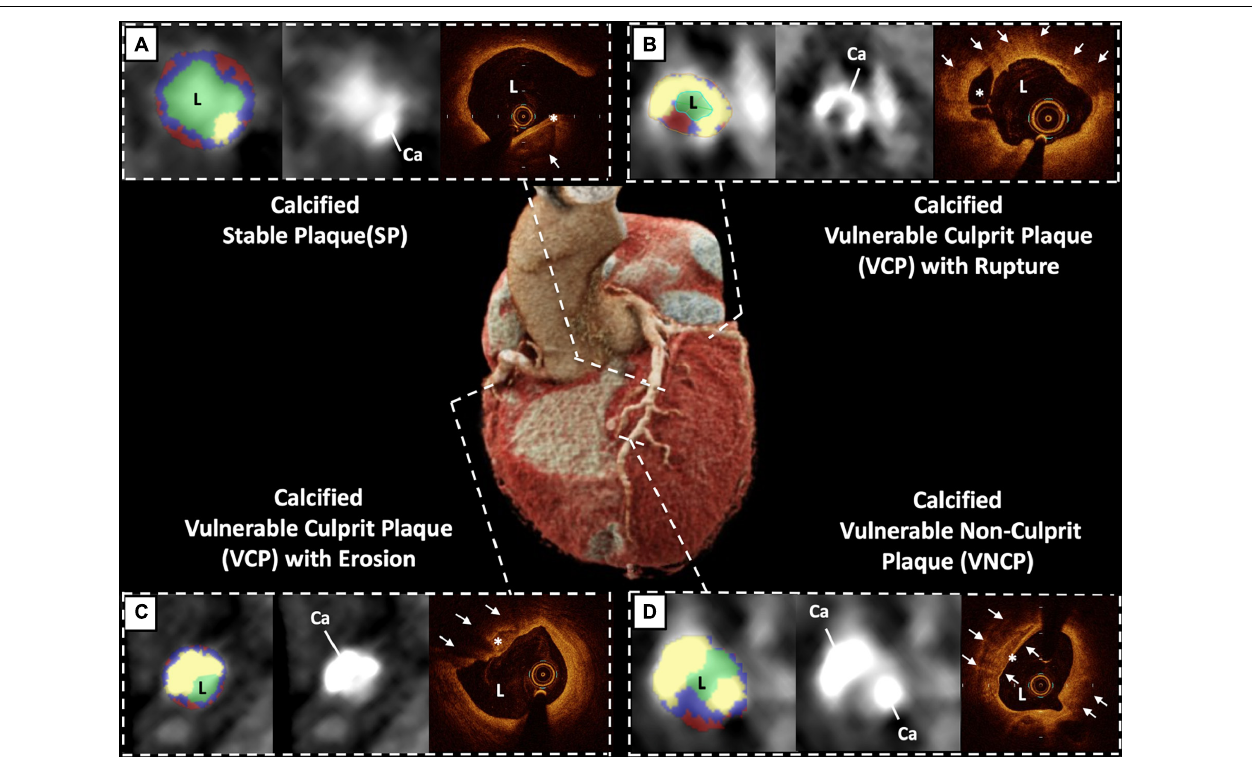
FIGURE 1 | Example of three different coronary calcified plaques studied by coronary computed tomographic angiography (CCTA) with matching optical coherence tomography (OCT) and “virtual histology” CCTA in the same patient. (A) stable plaque (SP): adventitious calcification (white arrow) with a thick fibrous screed ≥ 65 microns (*) at the mean LAD level. (B) vulnerable culprit plaque (VCP) with plaque rupture: large intimal quasi-circumferential calcification with a calcification arc at 240 ◦ (white arrows) with rupture of white thrombotic plaque (*) at the level of the proximal circumflex artery. (C) VCP with plaque erosion: large intimal calcification bulging toward the light (white arrows) with disappearance of the intima opposite (*) at the level of the proximal right coronary artery. (D) vulnerable non-culprit plaque (VNCP): intimal calcification (white arrows) with a fine fibrous screed < 65 microns (*) at the distal left anterior descending artery. Abbreviations: Ca, Calcification; CCTA, coronary computed tomographic angiography; L, Lumen; OCT, optical coherence tomography; SP, stable plaque; VNCP, vulnerable non-culprit plaque; VCP, vulnerable culprit